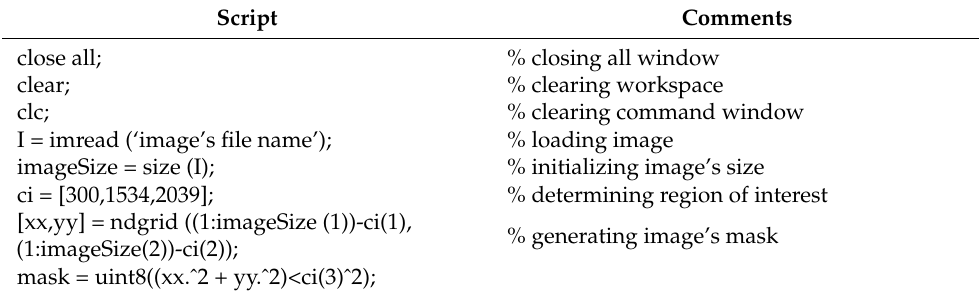
Table A1. Image-processing